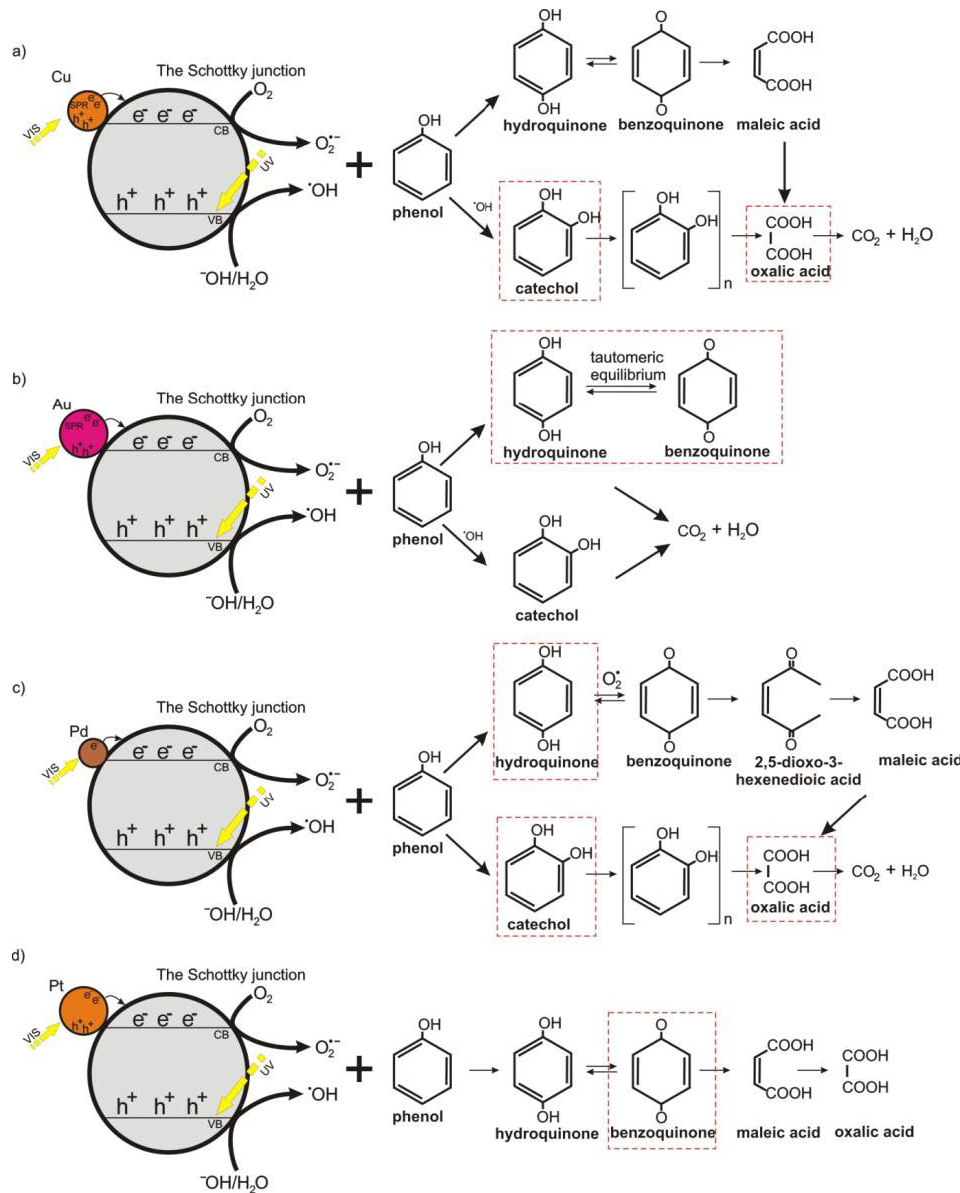
Figure 10. Schematic illustration of the phenol photocatalytic degradation mechanism for TiO 2 /SiO 2 @Fe 3 O 4 magnetic catalysts modified with: ( a ) copper; ( b ) gold; ( c ) palladium, and ( d ) plat- inum nanoparticles. Reproduced with permission from ref. [75]. Copyright 2018 MDPI.